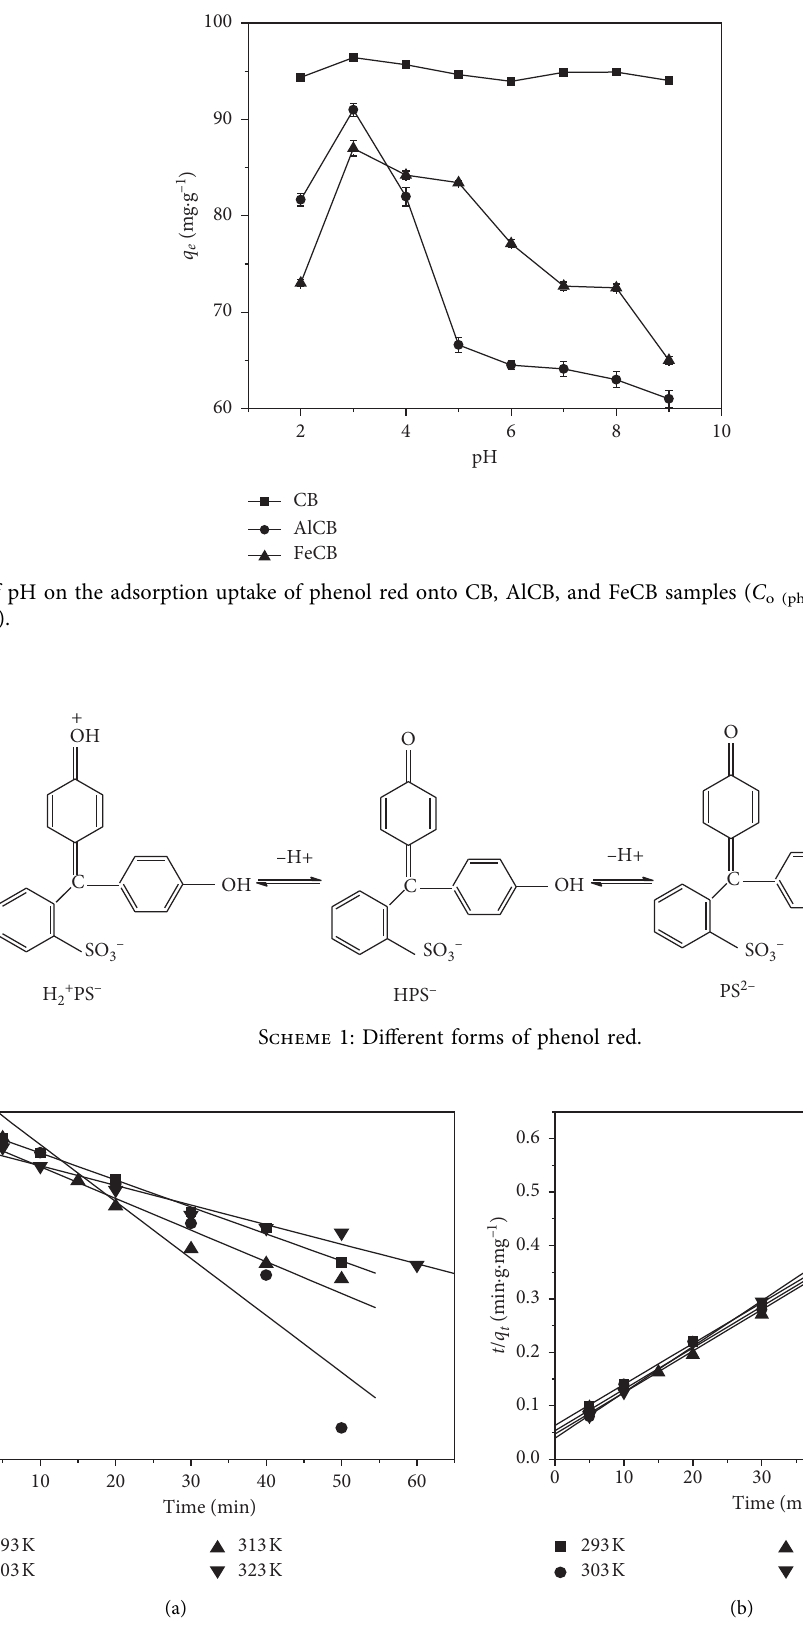
Figure 8: (a) The pseudo-first-order kinetic model and (b) pseudo-second-order kinetic model of phenol red adsorption by CB at different temperatures ( C o (phenol red) � 100mgL − 1 , pH 3.0, m �